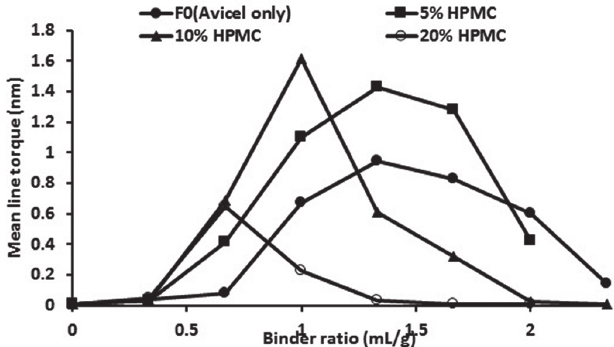
FIGURE 2 - Effect of different concentrations of HPMC K10 on mean torque of Avicel PH101 ® wet masses.